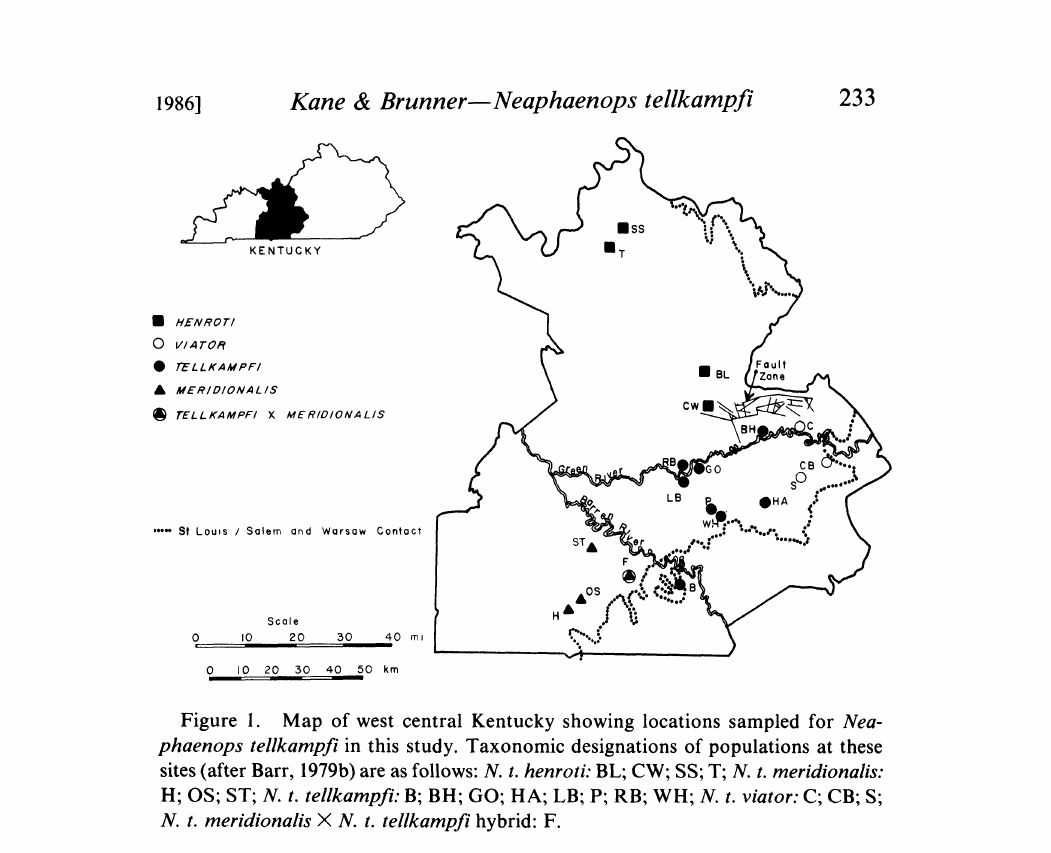
Figure 1. Map of west central Kentucky showing locations sampled for Nea- phaenops tellkampfi in this study. Taxonomic designations of populations at these sites (after Barr, 1979b) are as follows: N. t. henroti: BL; CW; SS; T; N. t. meridionalis: H; aS; ST; N. t. tellkampfi: B; BH; GO; HA; LB; P; RB; WH; N. t. viator: C; CB; S; N. t. meridionalis )< N. t. tellkampfi hybrid: